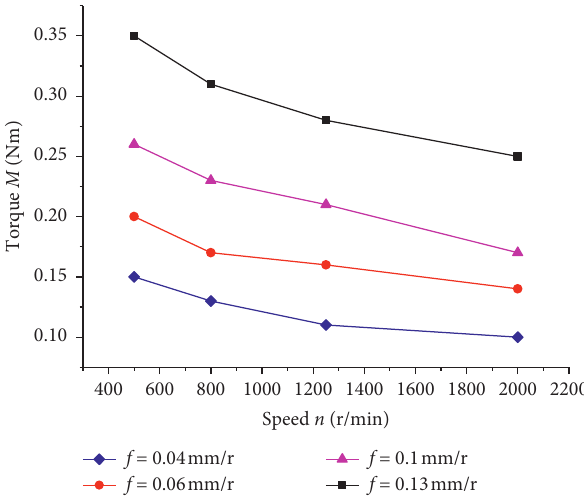
Figure 22: Torque at the varying experimental parameter.